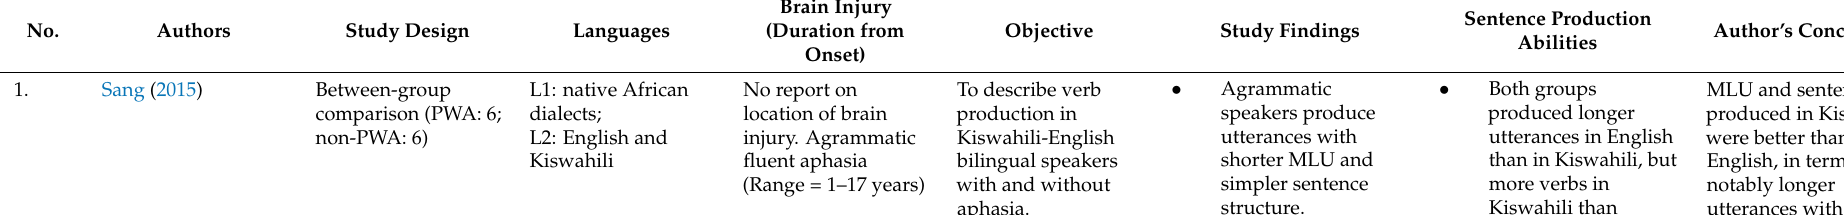
Table 3. Language Production among PWA: Comparison between L1 and